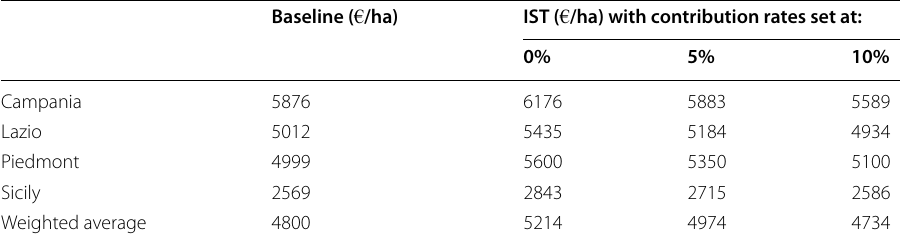
Table 2 Average GM levels by region. Baseline conditions and simulated implementation of the IST Baseline ( € /ha) IST ( € /ha) with contribution rates set at: 0%